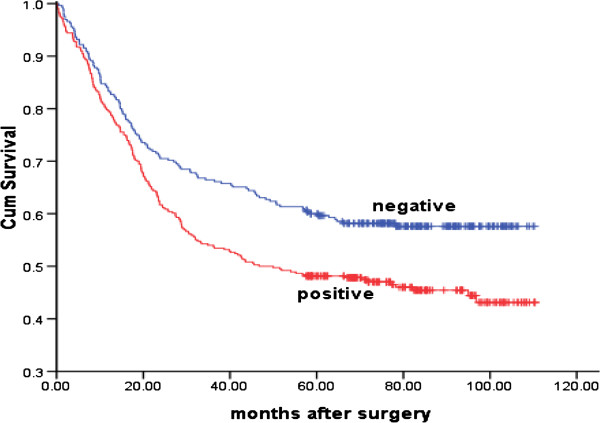
Association between SLC38A1 expression and survival duration in patients with gastric cancer. Kaplan-Meier survival analysis showed median survival of 46.69vs.69.7 months in patients with positive vs. negative SLC38A1 expression (P = 0.002).